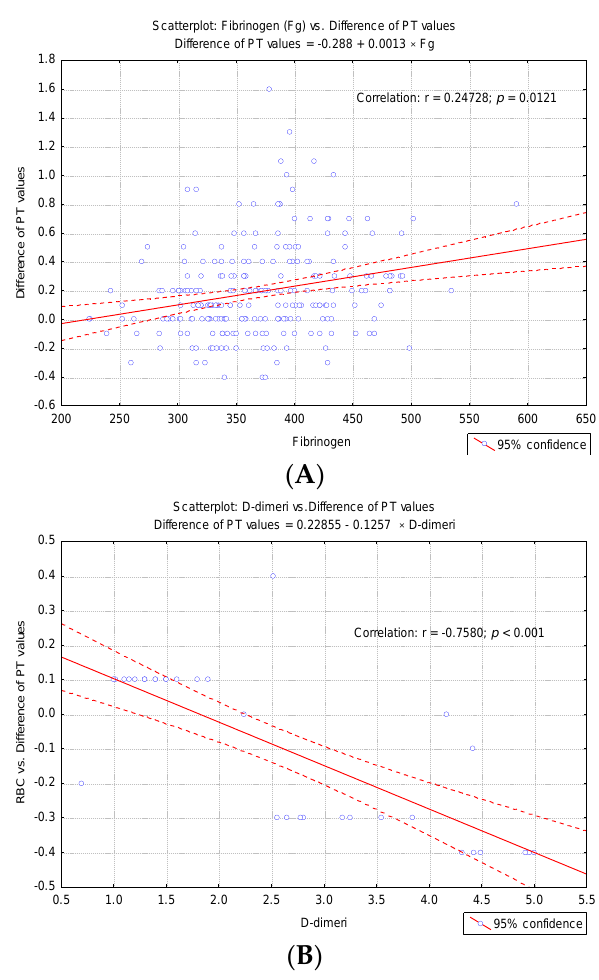
Figure 5. Regression line describing the variance of the difference between the PT test according to